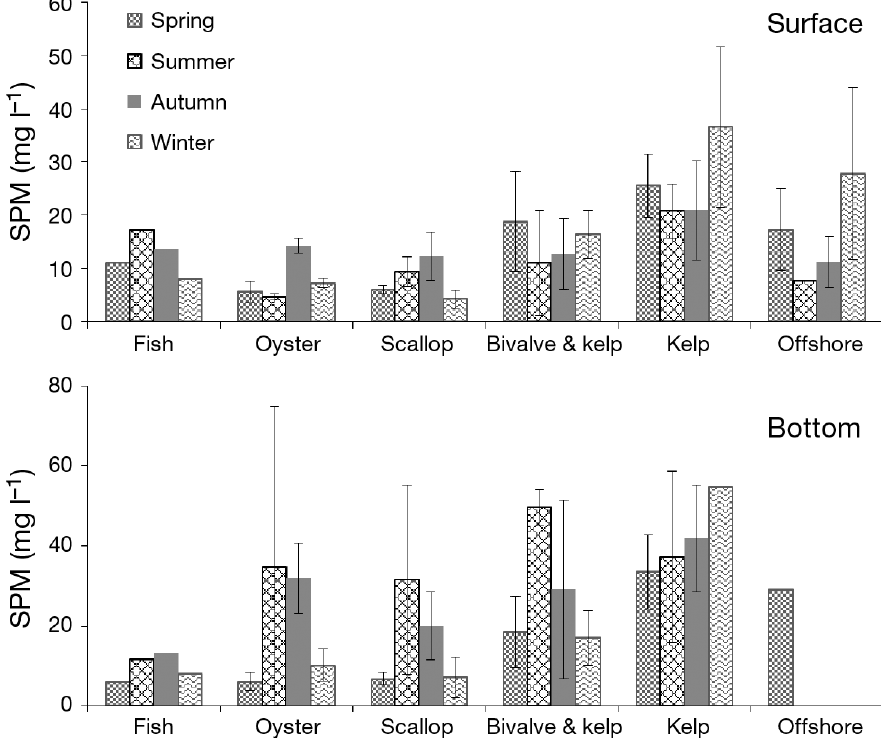
Fig. 3. Suspended particulate matter (SPM) concentrations (mg l −1 ; mean ± SD) in various cultivation areas in different seasons during the study